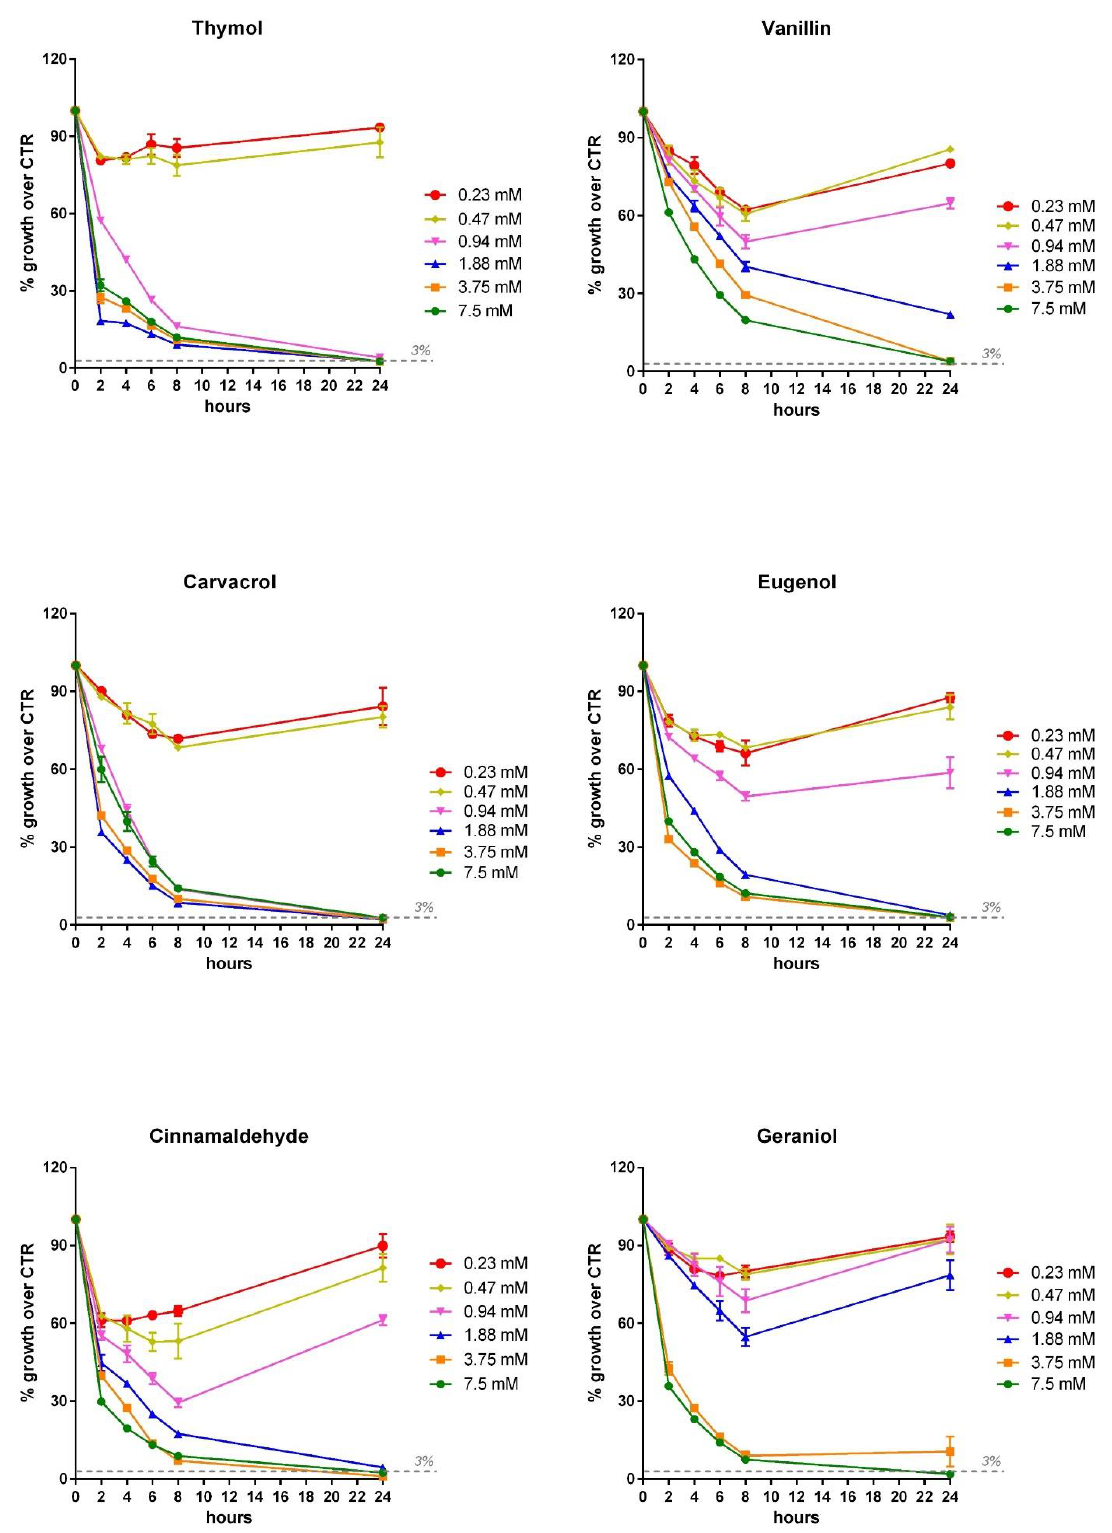
Figure 8. Inhibition dose–response growth of V. harveyi strain following 2, 4, 6, 8 and 24 h of incubation with the different OA and NIC that showed MIC values. V. harveyi growth is expressed as a percentage of growth relative to control strain and values are presented as the mean ± SEM ( n = 3). Each concentration of OA or NIC is represented with a different color, as shown in the legend close to each graph.